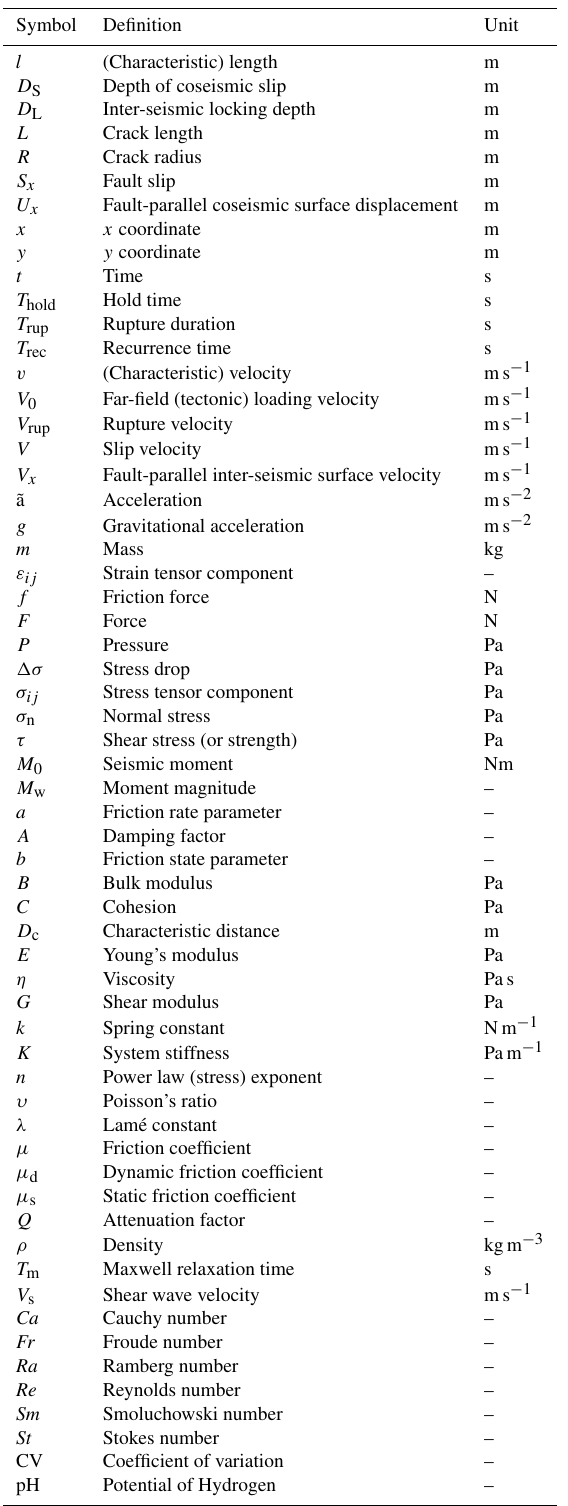
Table 6. Symbols and their meaning as used in this